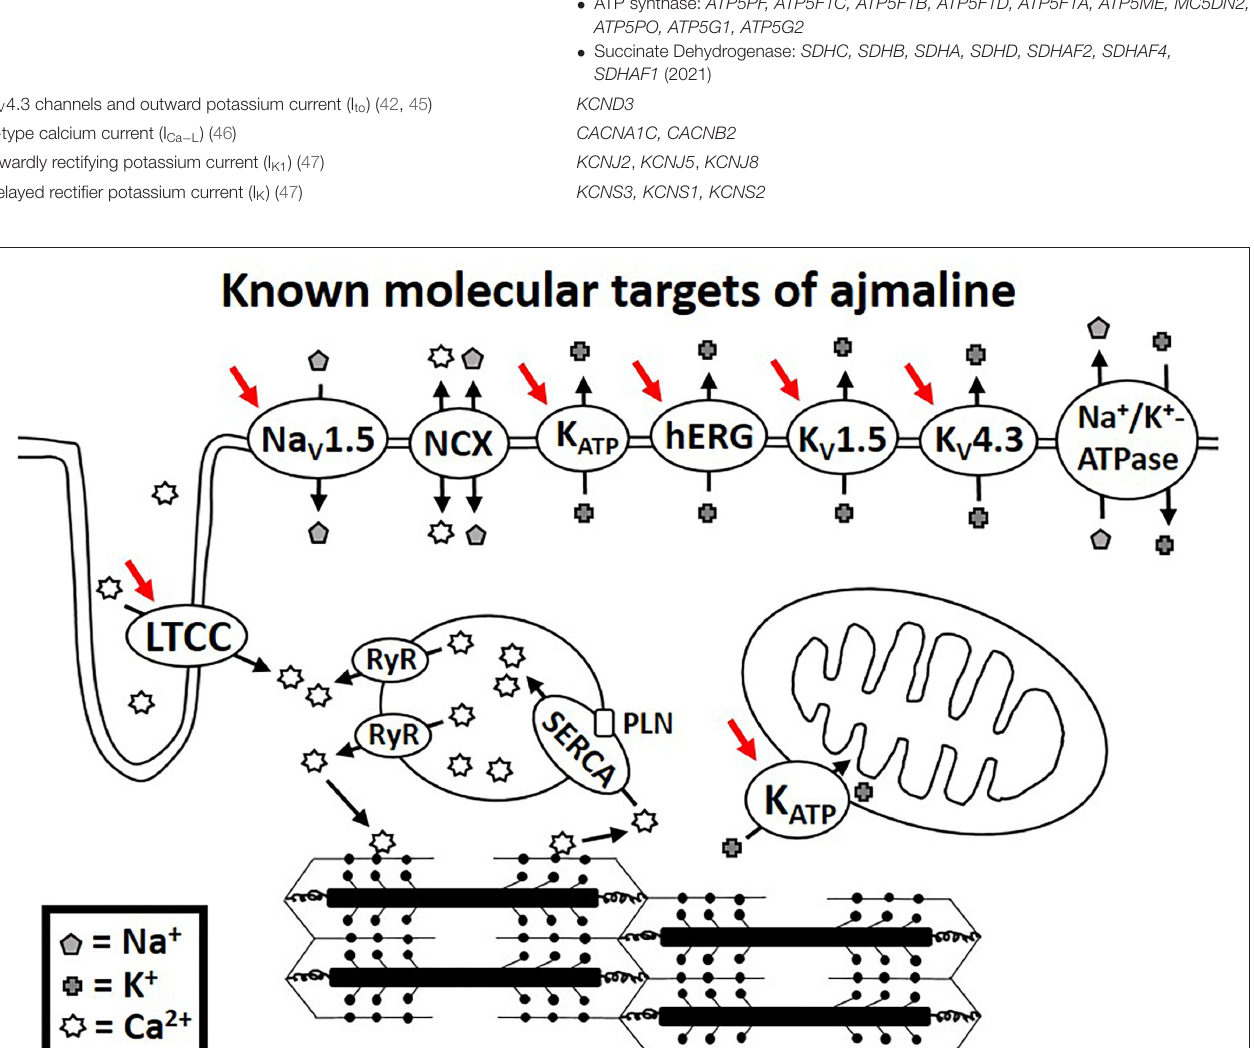
been found in BrS patients (27, 66, 67). Several other genes, encoding signaling and scaffolding proteins, including AKAP9